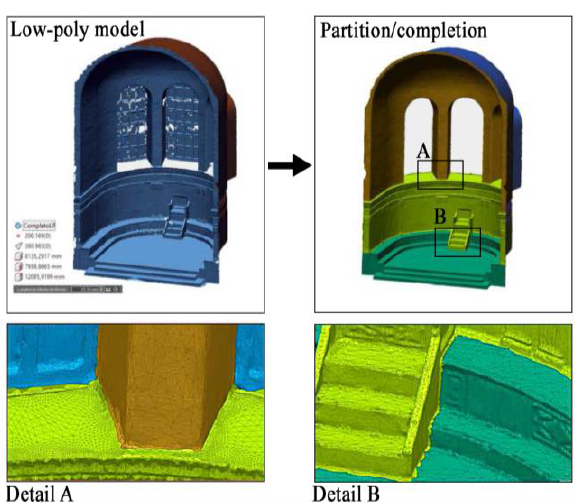
Figure 10. Maritime Theatre digital model: application of semantics and different optimization techniques in order to enrich the model, reach CSG, as well as texture reliability .